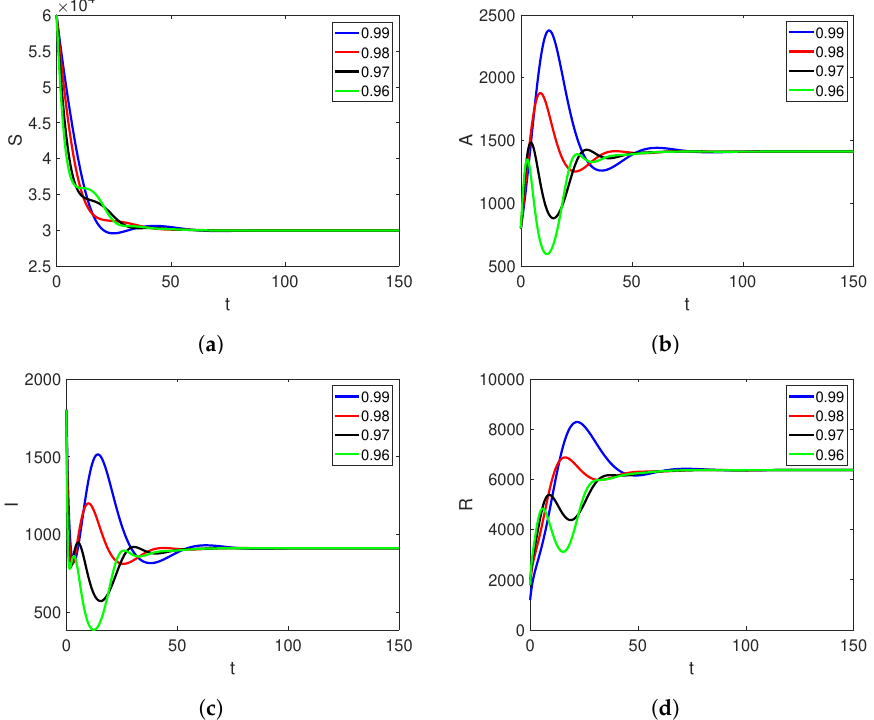
Figure 3. The dynamics of the state variables’ SAIR in model (2) with different fractional orders α vs. time t with initial